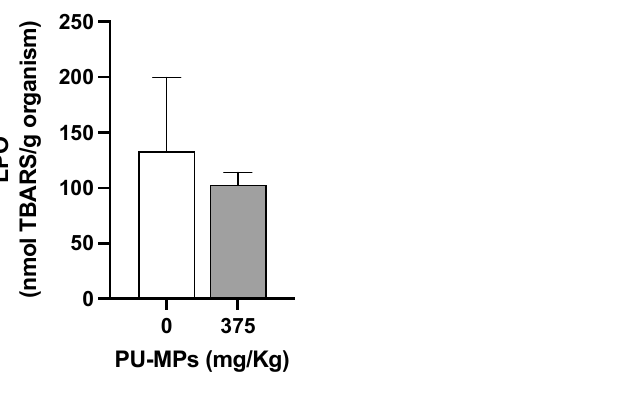
Figure 6. Lipid peroxidation (LPO) levels in Chironomus riparius larvae after 10 days of exposure to polyurethane microplastics (PU-MPs) (n = 5). All values are presented as mean ± standard error of the mean. No significant differences between treatments were denoted.